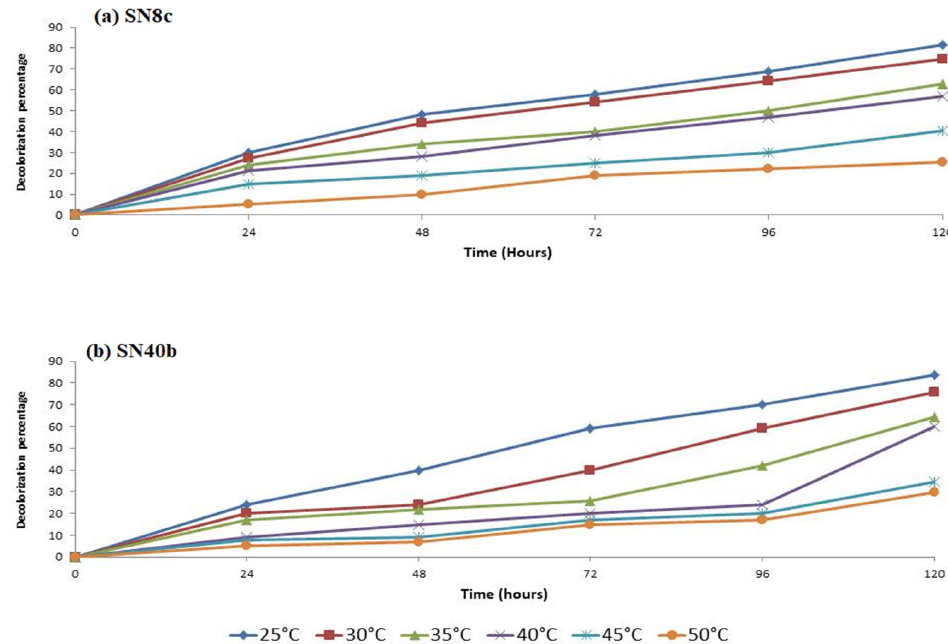
Figure 3. The effect of temperature on the decolorization of RBB dye.